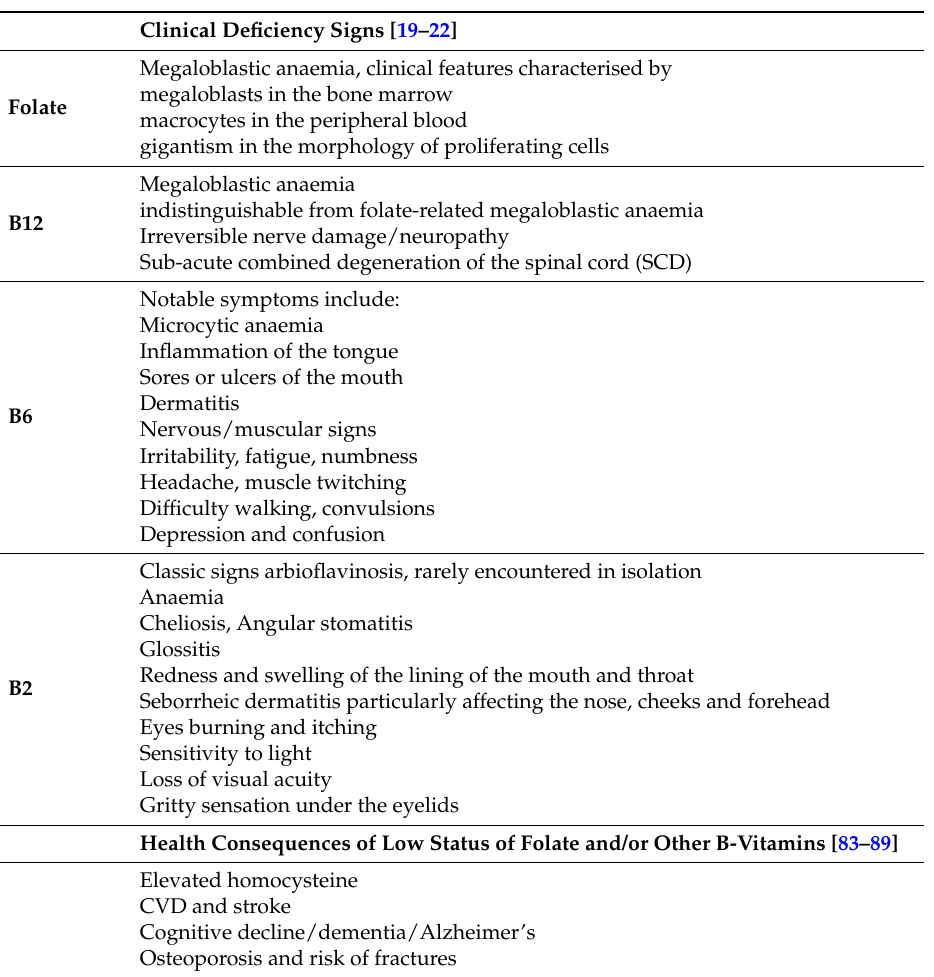
Table 3. Consequences of deficient or low status of